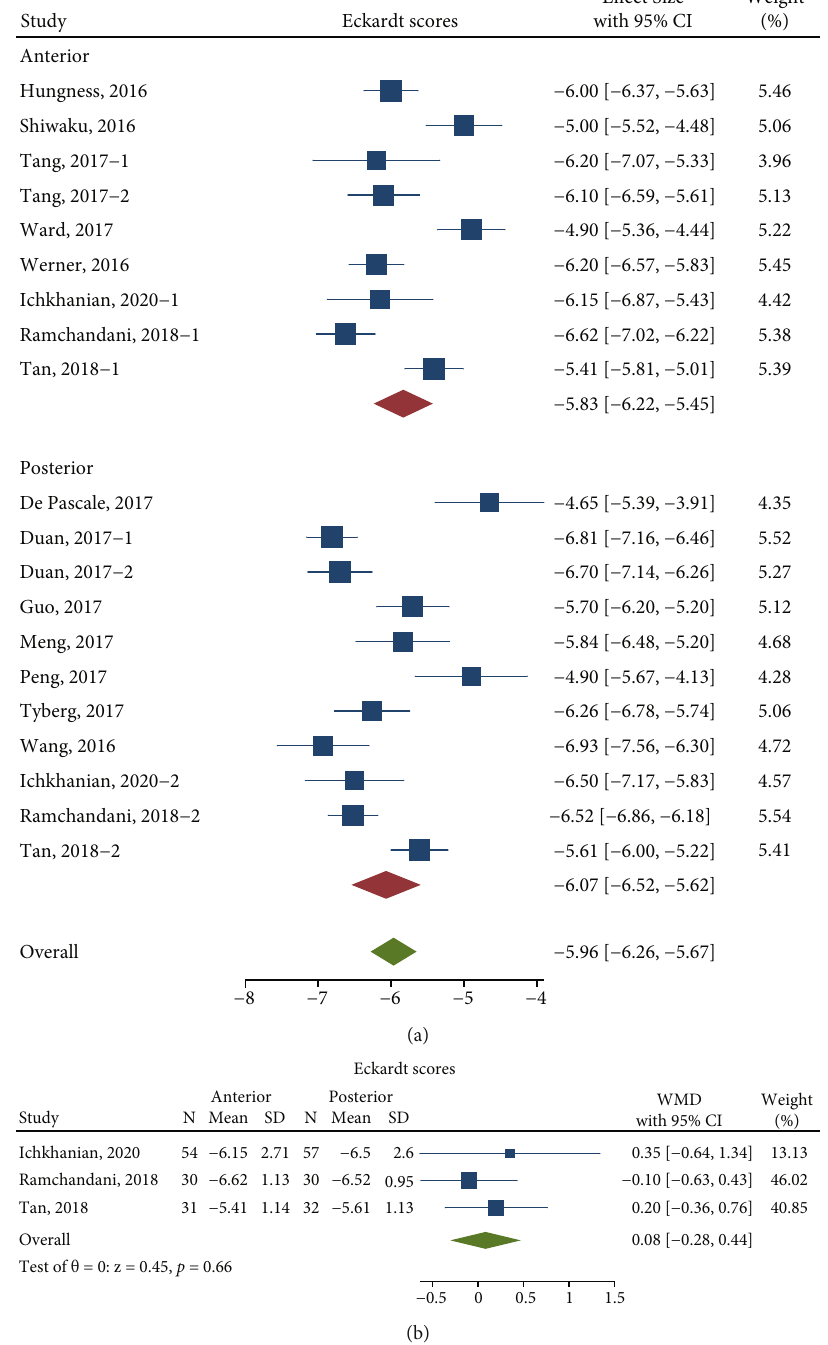
Figure 3: (a) Forest plot, di ff erence in pre- and postoperative Eckardt scores before balancing baseline; (b) Forest plot, Di ff erences in the pre- and postoperative Eckardt scores of the anterior and posterior approaches after balancing baseline Labels 1 and 2 were sectionalizations inside the study. They grouped these factors as follows: preoperative intervention/non-preoperative intervention (Tang, 2017), FTM/CM (Duan, 2017), Chagas/idiopathic (Farias, 2020), and anterior/posterior (Ramchandani, 2018; Tan,